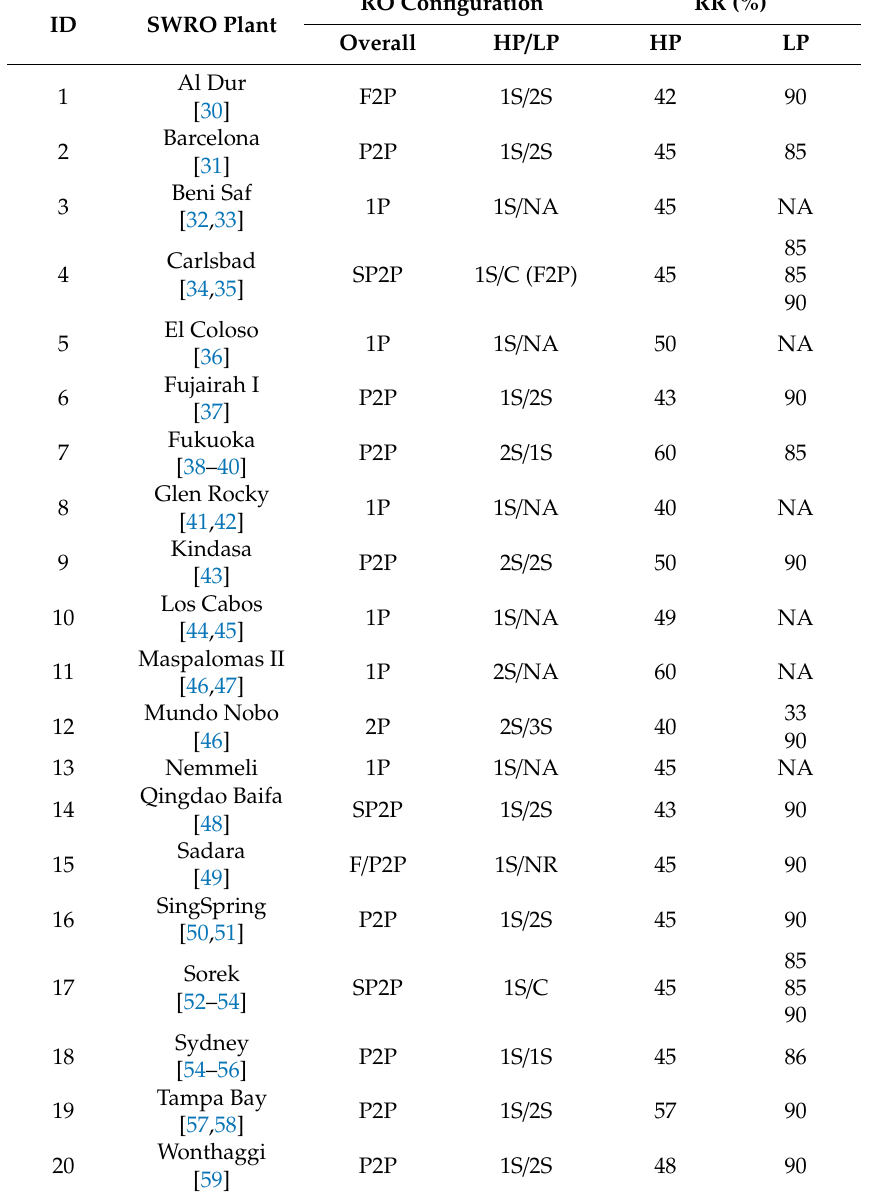
RO configurations (Figure A1): Full two-pass (F2P); Partial two-pass (P2P); Split partial two-pass (SP2P); Single-pass (1P); Single-stage (1S); Two-stage (2S), Cascade (C); RR: Water recovery rate; HP: High pressure RO pass; LP: Low pressure RO